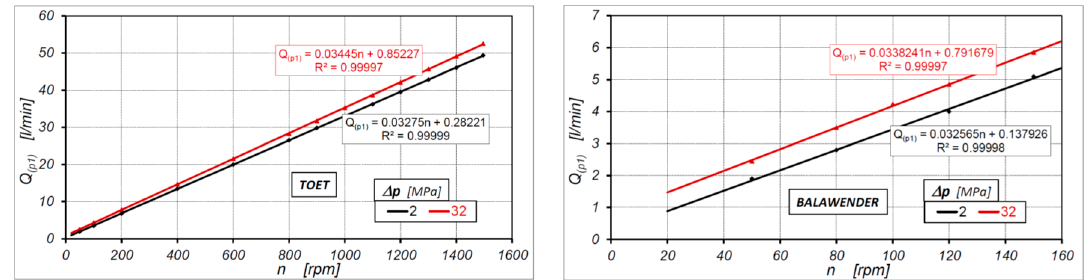
Figure 13. Characteristics of motor output flow rate Q (p1) related to pressure p 1 in the motor inflow port vs. rotational speed n at Δ p = const. On the left—Toet’s method; on the right—Balawender’s method.